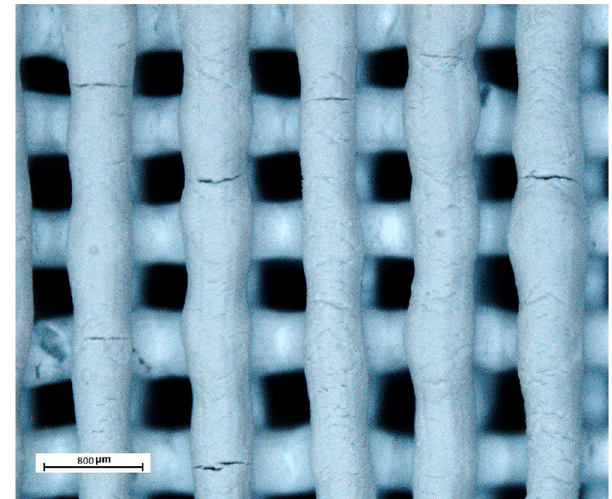
Figure 2. Stereomicroscope observation of a dried porous sample fabricated from P2 indicating drying cracks on the filaments’ surfaces.